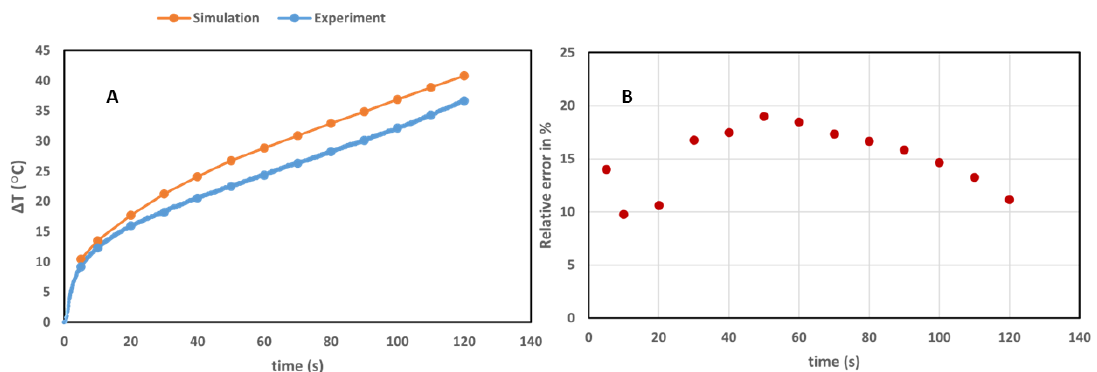
Figure 5. ( A ) Temperature increases at 2 mm distance from the tip of the laser applicator (diameter of 0.3 mm) guiding 808 nm laser light for the ex vivo (blue curve) and simulated (orange curve) pancreas, at a power of 2.1 W. ( B ) Relative error between the experimental data and simulation.